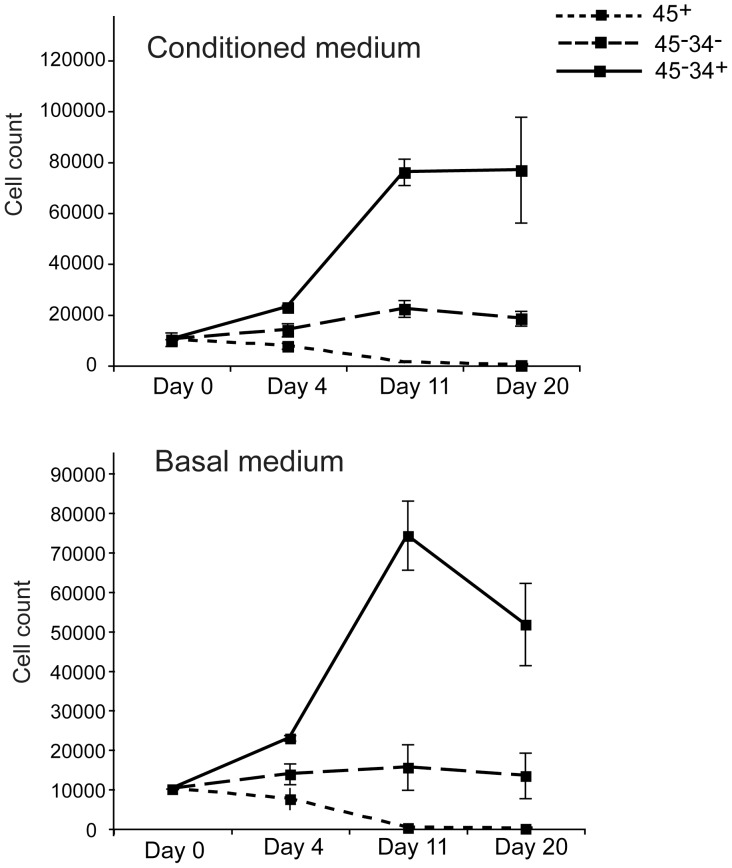
Survival and expansion of omentum cell subsets ex vivo.Omentum cells were separated into CD45+, CD45−CD34+, and CD45−CD34− subsets and cultured in the conditioned medium for lung epithelium differentiation (upper panel) or in the basal medium. Cell numbers for each group were counted on days as indicated in triplicate.